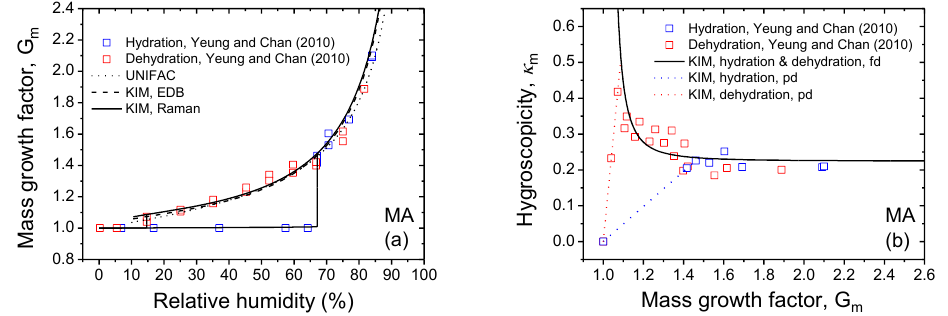
Figure 4: Hygroscopic properties of crystalline malonic acid (MA) particles: (a) mass growth factors ( G m ) observed as a function of relative humidity; (b) mass-based hygroscopicity parameters ( κ m ) calculated as a function of mass growth factor (Eq. 10). Data points: micro-Raman experiments of hydration (blue) and dehydration (red) from Yeung and Chan (2010). Model lines: (a) UNIFAC with interaction parameters from Peng et al. (2001) – black dotted; KIM fit to micro-Raman data – black solid; KIM with fit parameters from EDB data for amorphous MA (Fig. 3b) – black dashed; (b) KIM for fully dissolved (fd) particles (Eq. 29) – black solid; KIM for partly dissolved (pd) particles (Eq. 28) – blue dotted upon deliquescence and red dotted upon efflorescence.